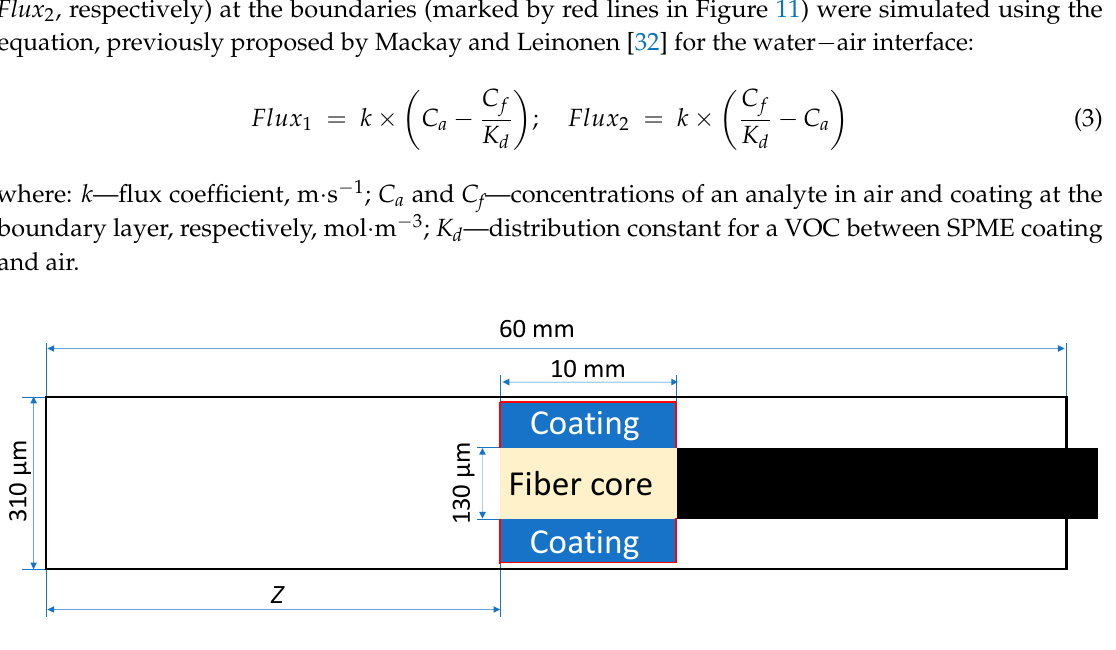
Figure 11. The geometry of SPME device (retracted inside a protective needle for TWA sampling) used for modeling. Note: red lines indicate the boundaries between air and coating.